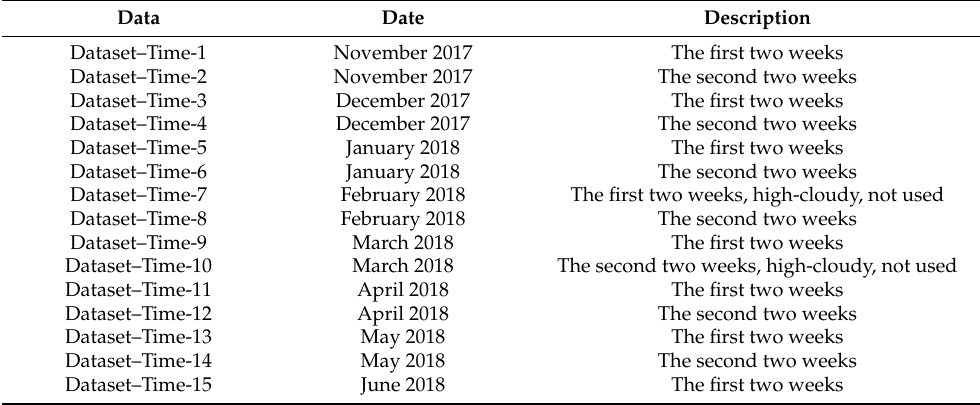
Table 1. Date and description of Sentinel-2 multispectral images that were used for crop mapping.